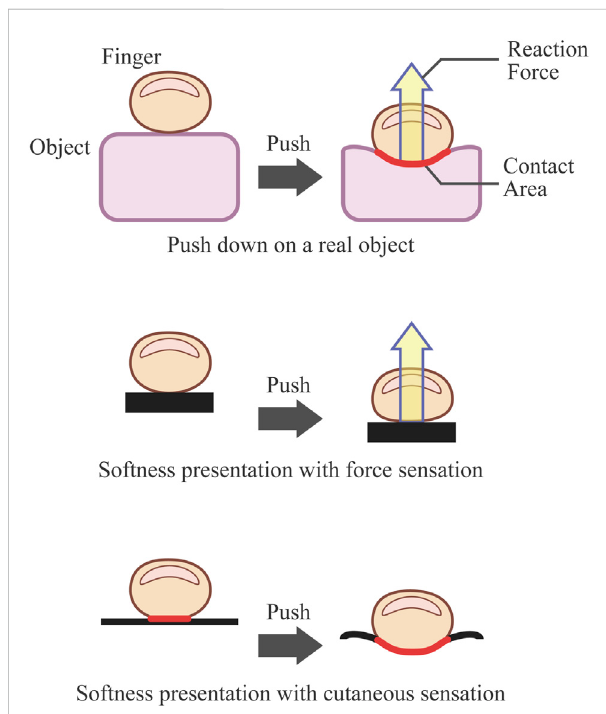
Conceptual diagram illustrating the presentation of softness through force sensation alone and through cutaneous sensation